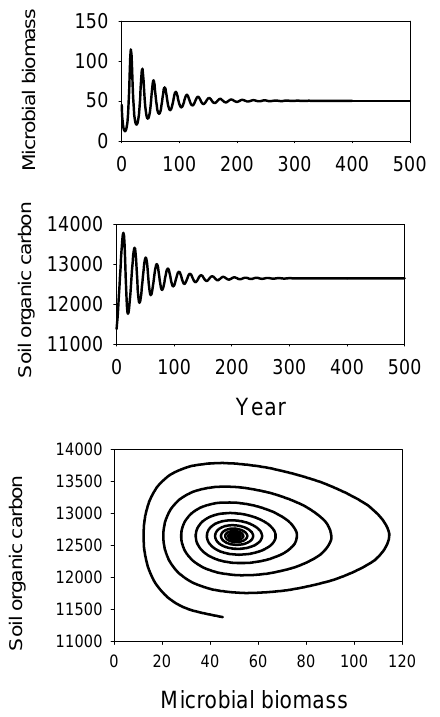
Fig. 2. Changes in microbial biomass (in gCm − 2 ; upper panel) or soil organic carbon (in gCm − 2 ; middle panel) (both in gCm − 2 , 0– 100cm soil depth) in time or soil organic carbon against microbial biomass (lower panel) following a 10% reduction in initial pool sizes at time t = 0 from their respective equilibrium values for the two-pool soil model. Soil temperature was constant at 15 ◦ C for this simulation.